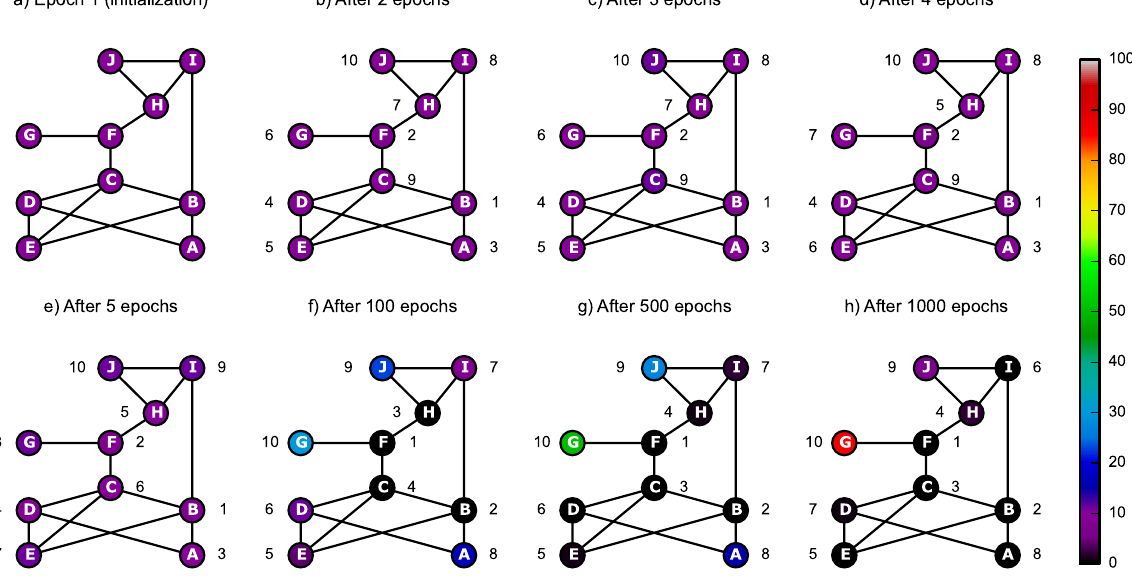
Figure 1. Thieves in action. Snapshots with the illustration of GOT behavior over epochs on a simple unweighted network with 10 nodes. Initially, we set Φ = 10 n vdiamonds and one thief per node, and we let the 0 game to run for 1000 epochs. The colormap gives the number of vdiamonds, Φ en , in any node (n) at epoch (e). The numbers on the side of each node show the rank of importance, Λ e , n , assigned by GOT to the specific node (n) after ( e ) epochs, where e = 1, 2, 3, 4, 5, 100, 500, and 1000 epochs in subplots a , b , c , d , e , f , g , and h